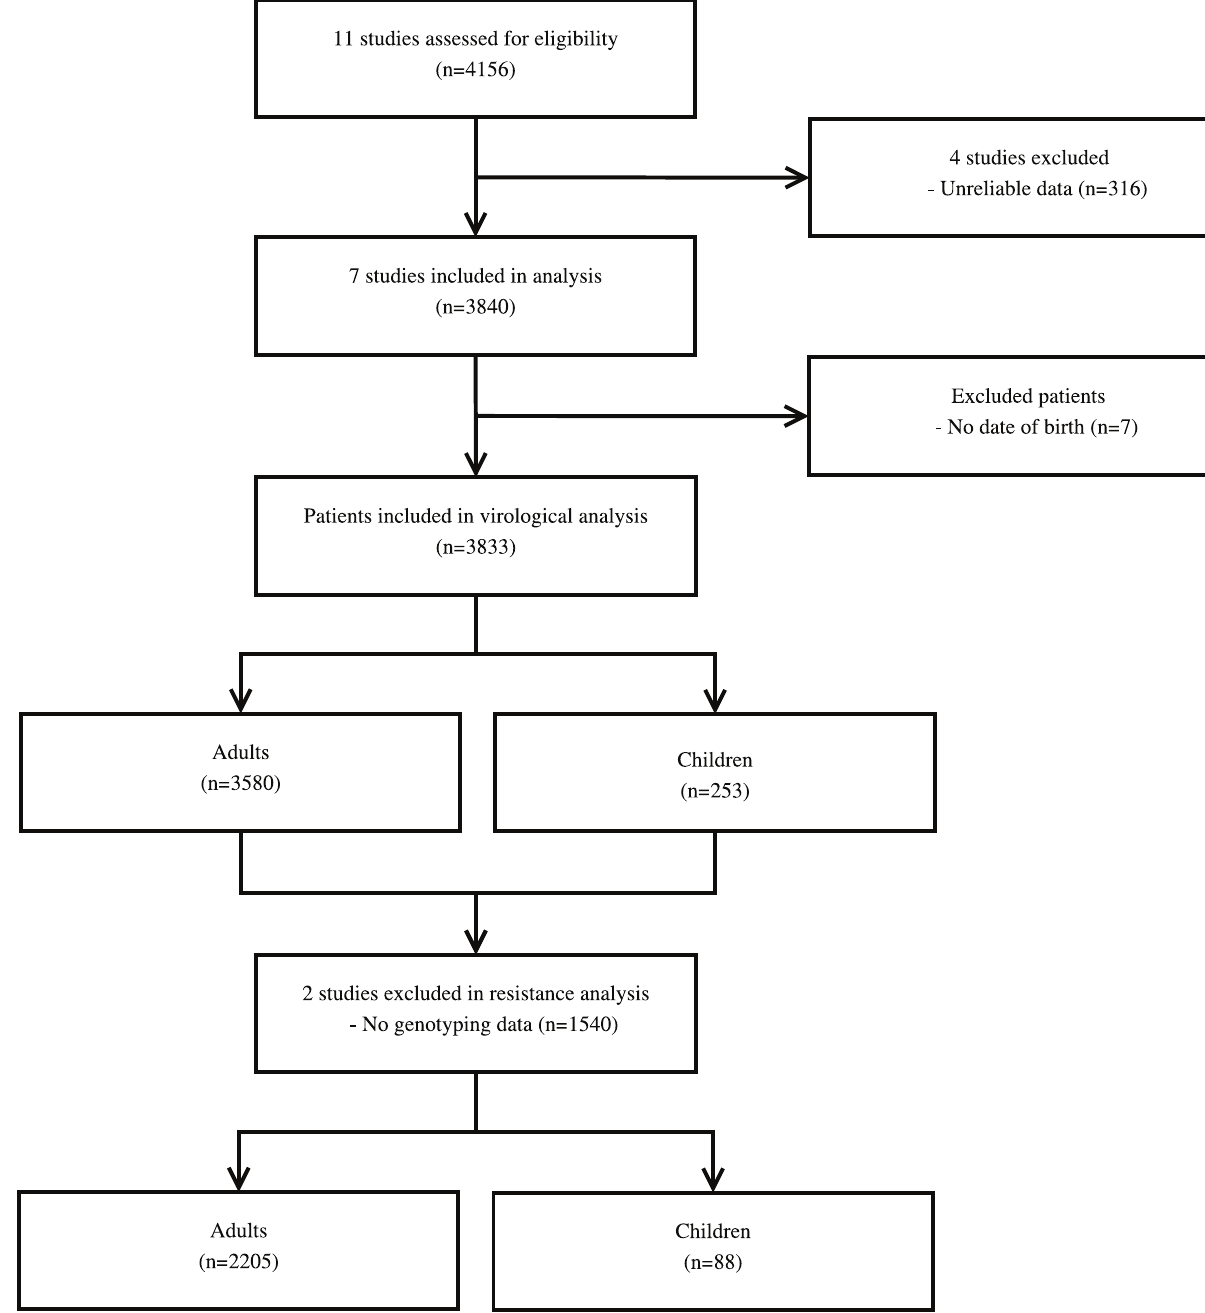
Figure 1. Flow chart of the patients included in the study.